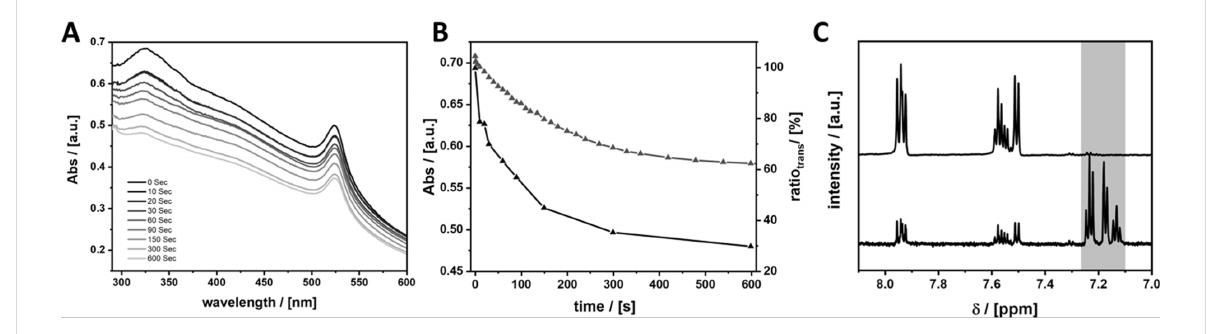
Figure 5: (A) UV–vis absorption kinetics of 3D-AzoC 2 in toluene over a time period of 600 s. (B) Decrease of the absorption band at 325 nm of AzoC 2 in H 2 O (grey) and 3D-AzoC 2 (black), which is caused by the photoswitching reaction. (C) 1 H NMR spectra of the dissolved 3D-AzoC 2 , top: before irra- diation, bottom: after 600 s of irradiation at 313 nm. Signals of the cis -isomer are highlighted in light grey. It turns out that longer irradiation times are necessary for 3D-AzoOC 12 to reach the photostationary state (see Supporting Information File 1, Figure S21H). It can be concluded, that the prox- imity to the perovskite improves the isomerisation under irradiation.